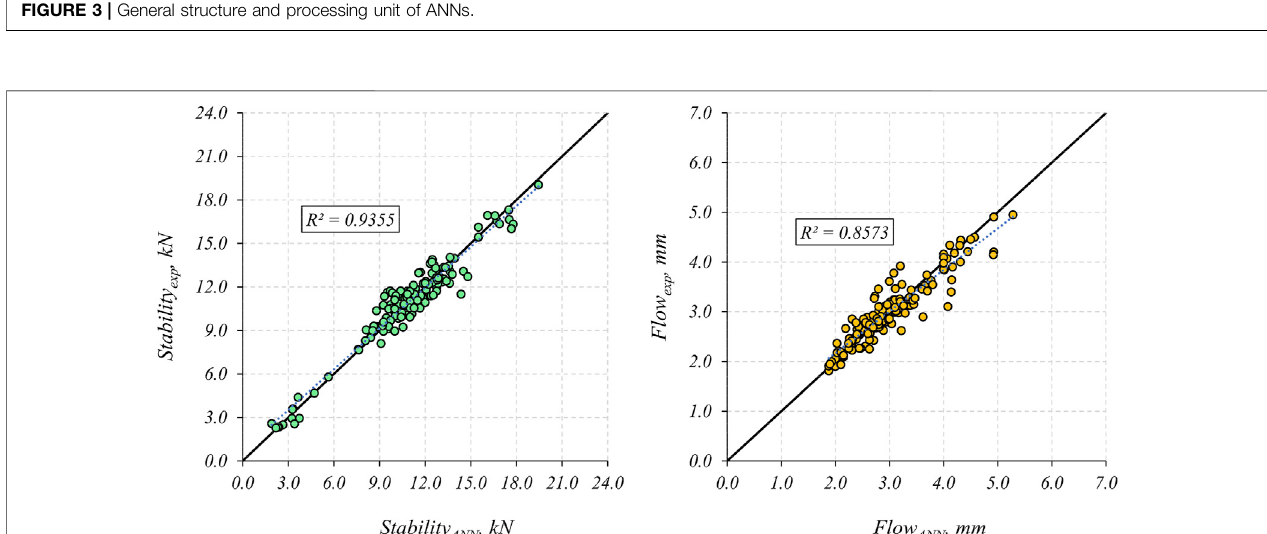
FIGURE 4 | General structure and processing unit of